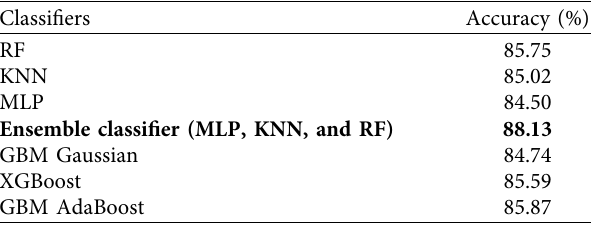
Figure 1: Proposed ensemble model for spam product reviews classification. Table 1: Classification results using all features on Yelp